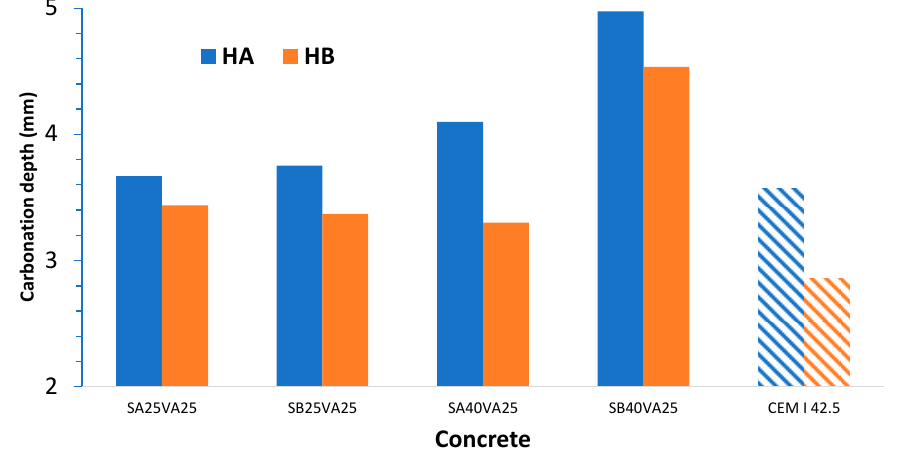
Figure 4. Carbonation depth of concrete samples at 12 months.